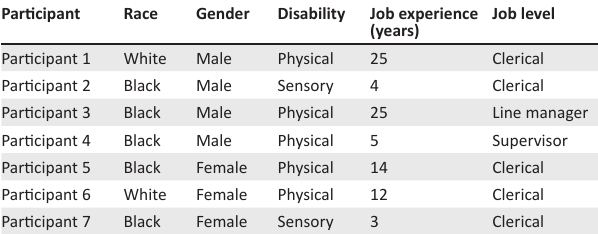
TABLE 2 Demographical information of study